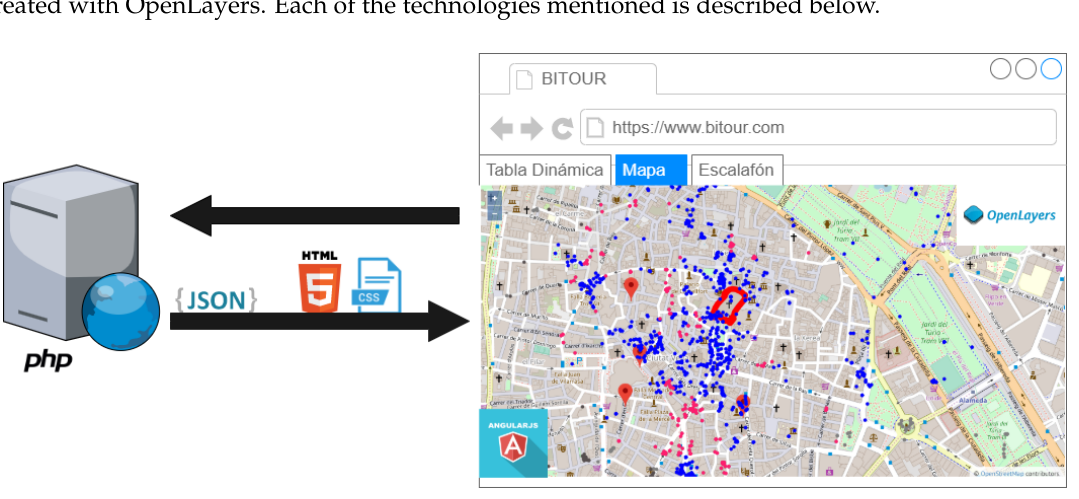
Figure 4. Visualization layer